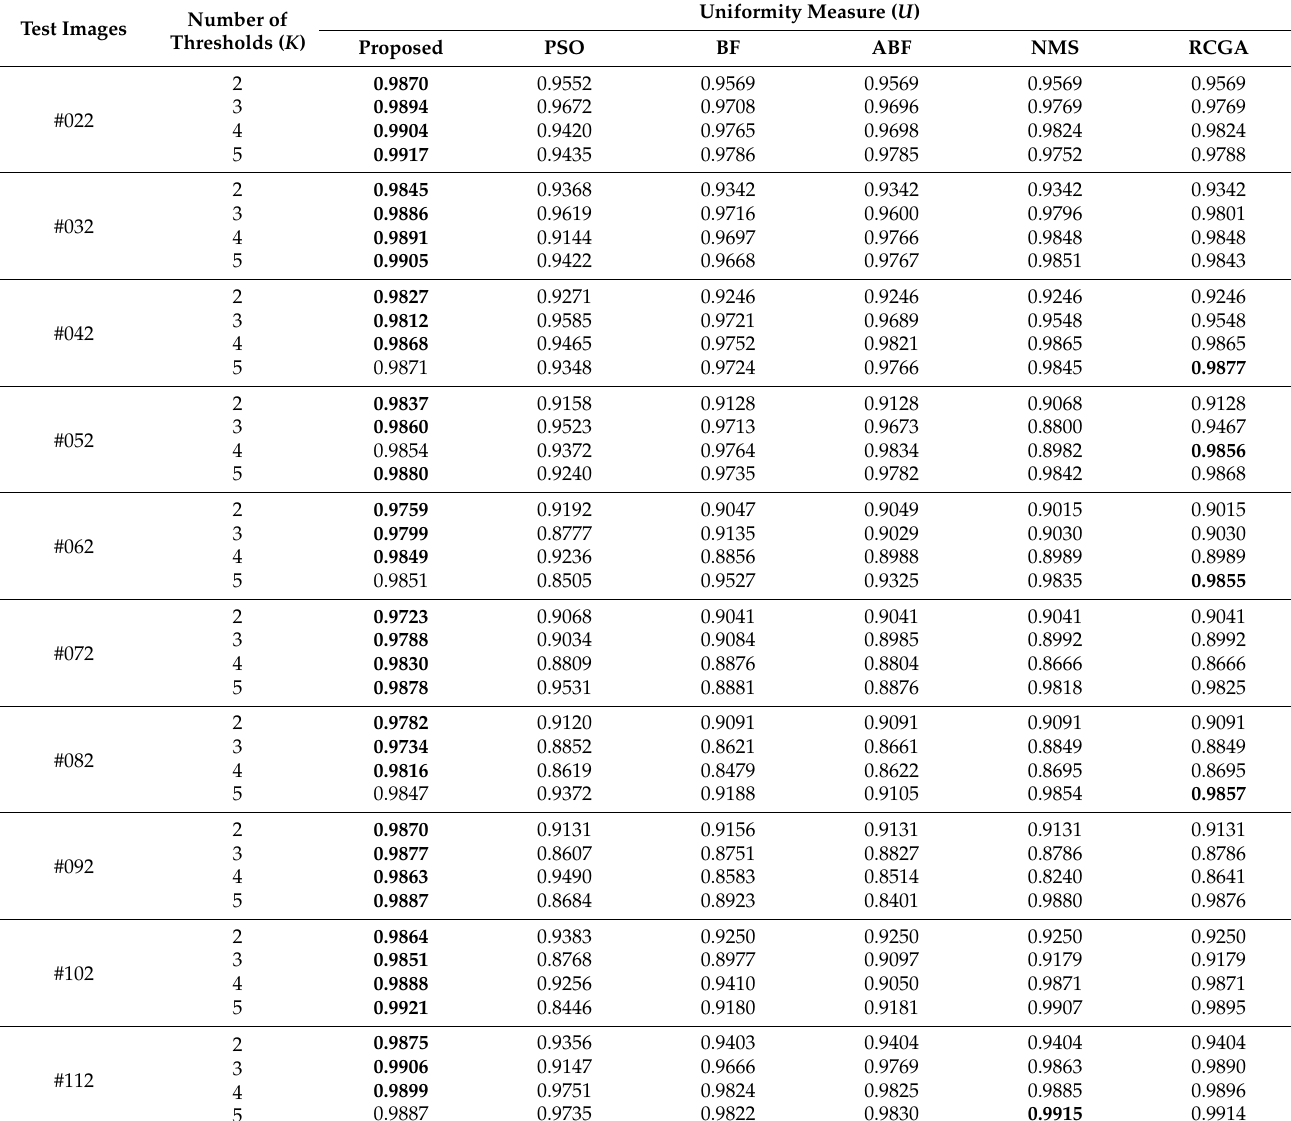
Table 2. Comparison of the uniformity measure for different segmentation algorithms.